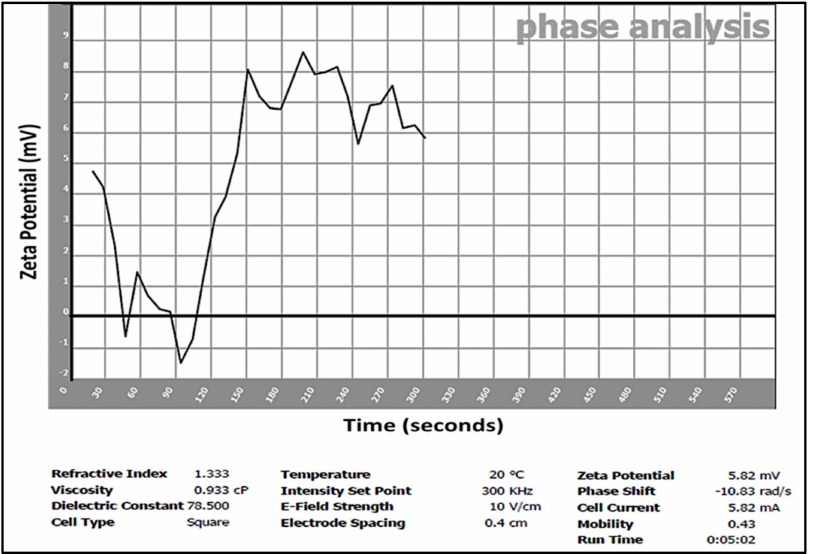
Figure 10. Zeta potential of ZnO NPs measured as a function of